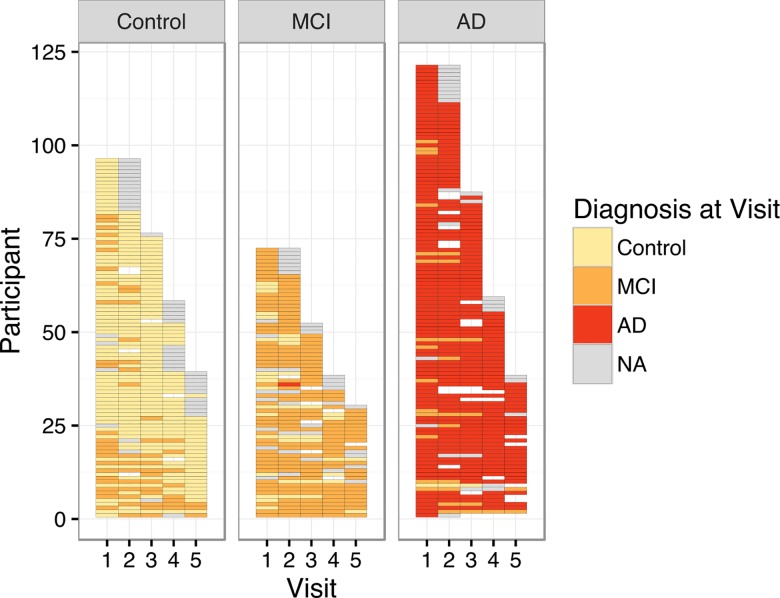
Clinical Diagnosis by Visit.Heatmap depicting the clinical diagnosis assigned to each participant at each study visit. The left panel represents participants whose most recent diagnosis was Control. The middle panel represents participants whose most recent diagnosis was MCI. The right panel represents participants whose most recent diagnosis was AD. Colors reflect the diagnosis made at a given visit, which does not always correspond to the most recent diagnosis. Participants' most recent visit may have occurred beyond the 5 visits used in the current study.